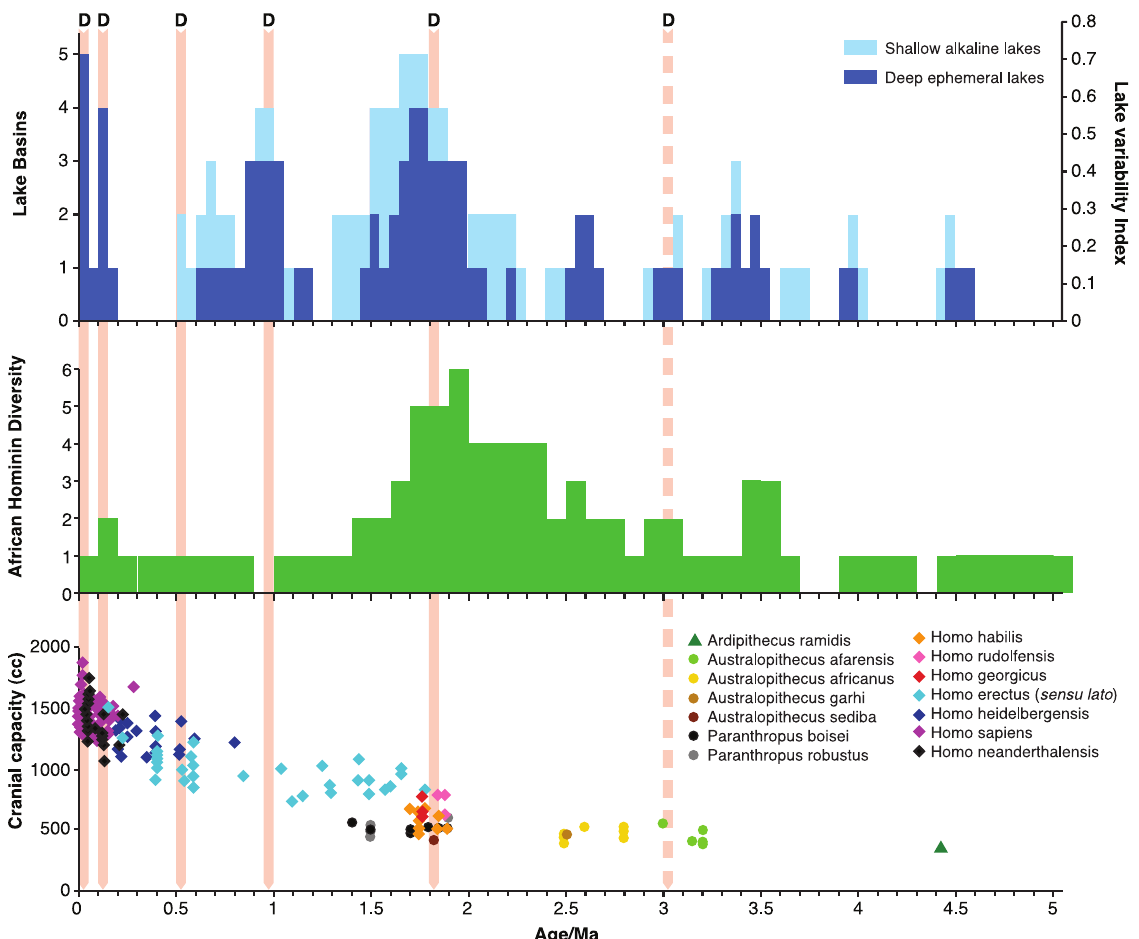
Figure 1. Top panel shows the East African Rift valley lake variability shown both as the number of Basin containing deep or shallow lakes and the calculated normalised lake index. The putative hominin dispersals ‘D’ (red arrows out of Africa, dotted within Africa only) are shown above. Middle panel shows African hominin species diversity over time. Bottom panel shows hominin brain estimates for Africa and Eurasia. Hominin specimen dates and brain size estimates were taken from Shultz et al [3]. East African hominin diversity at each 100 kyrs interval were estimated using first (FAD) and last appearance dates (FAD) from the literature [2,35–36,46]. Homo erectus and H. ergaster were treated as a ‘super-species’ referred to in the Figure key and text as ‘ Homo erectus (sensu lato) ’, but distinct regional processes in brain size change were identified by separating the specimens by continent in the analyses. Hominin migration dates were estimated by FAD of hominin specimens outside of EARS. Lake variability index was calculated by collating the published geological evidence for the appearance of either deep ephemeral or shallow alkaline lakes in seven major Basins [15,17,23–27,34–37]. The index was normalised by dividing by 7 to produce a range from 0 to 1.